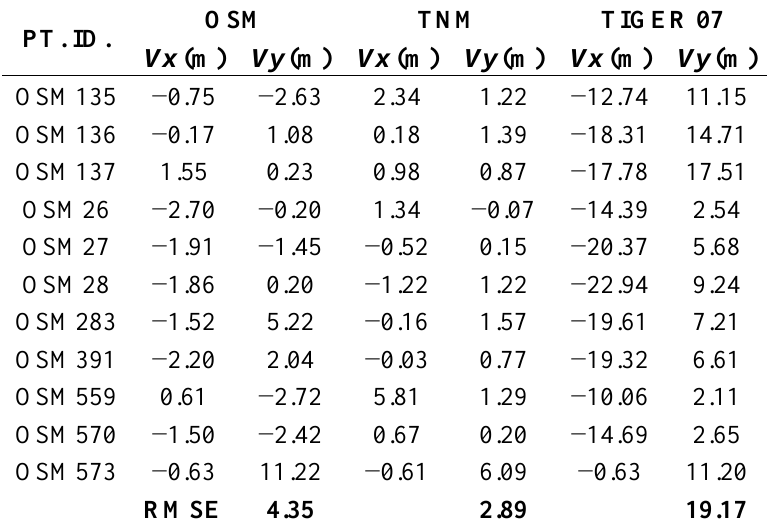
Table 6. Adjustment residuals for OSM, TNM, and TIGER 07